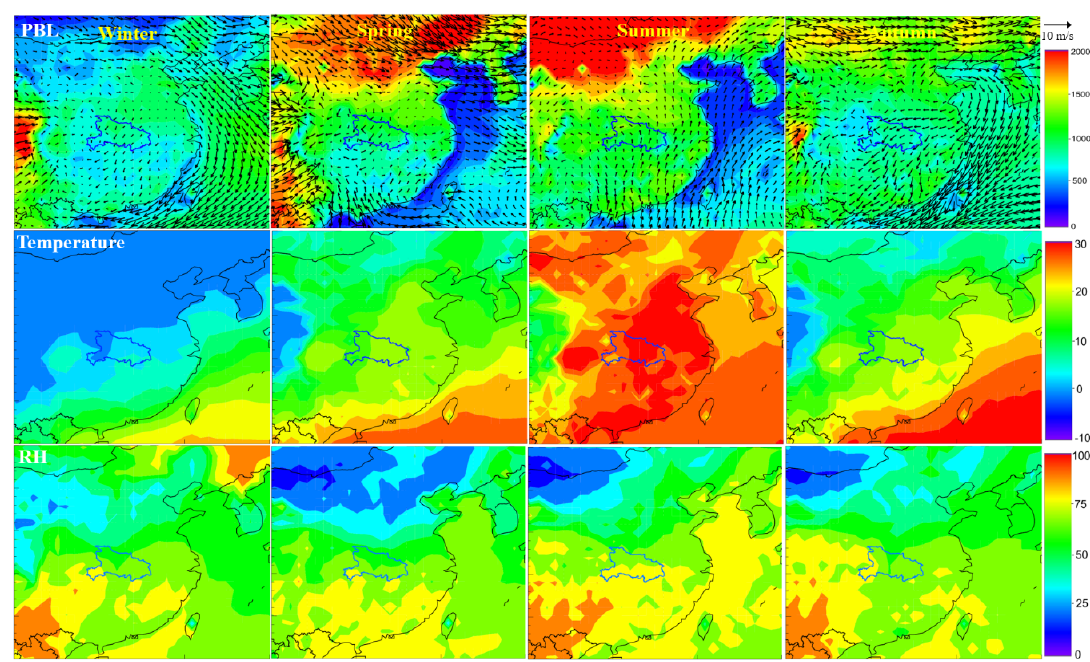
Figure 2. Seasonal characteristics of the meteorological conditions including height (m) of the planetary boundary layer (PBL) with 925 hPa winds (top), temperature (°C) (middle), and relative humidity (%) (RH) (bottom) at 14:00 local time of 2017 in eastern China.